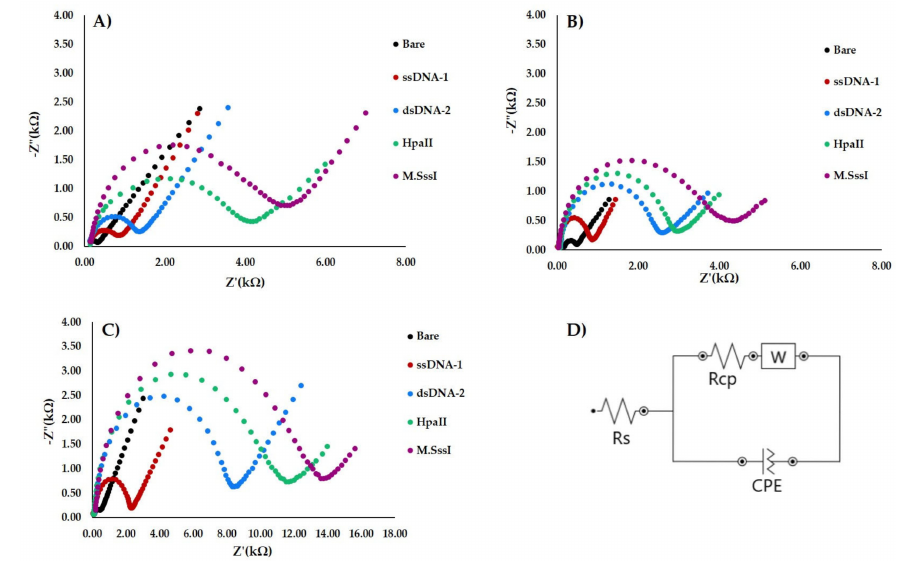
Figure 4. Electrochemical impedance spectroscopy (EIS) characterization of the electrodes prepared by di ff erent nanocomposites, where the Nyquist plot was recorded. ( A ) rGO-AgNPs, ( B ) rGO-CuNPs, ( C ) rGO-AuNPs and its ( D ) equivalent